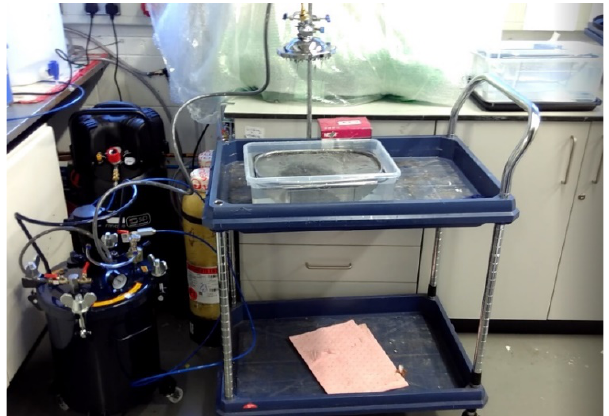
Figure 1. Capsule production laboratory system.